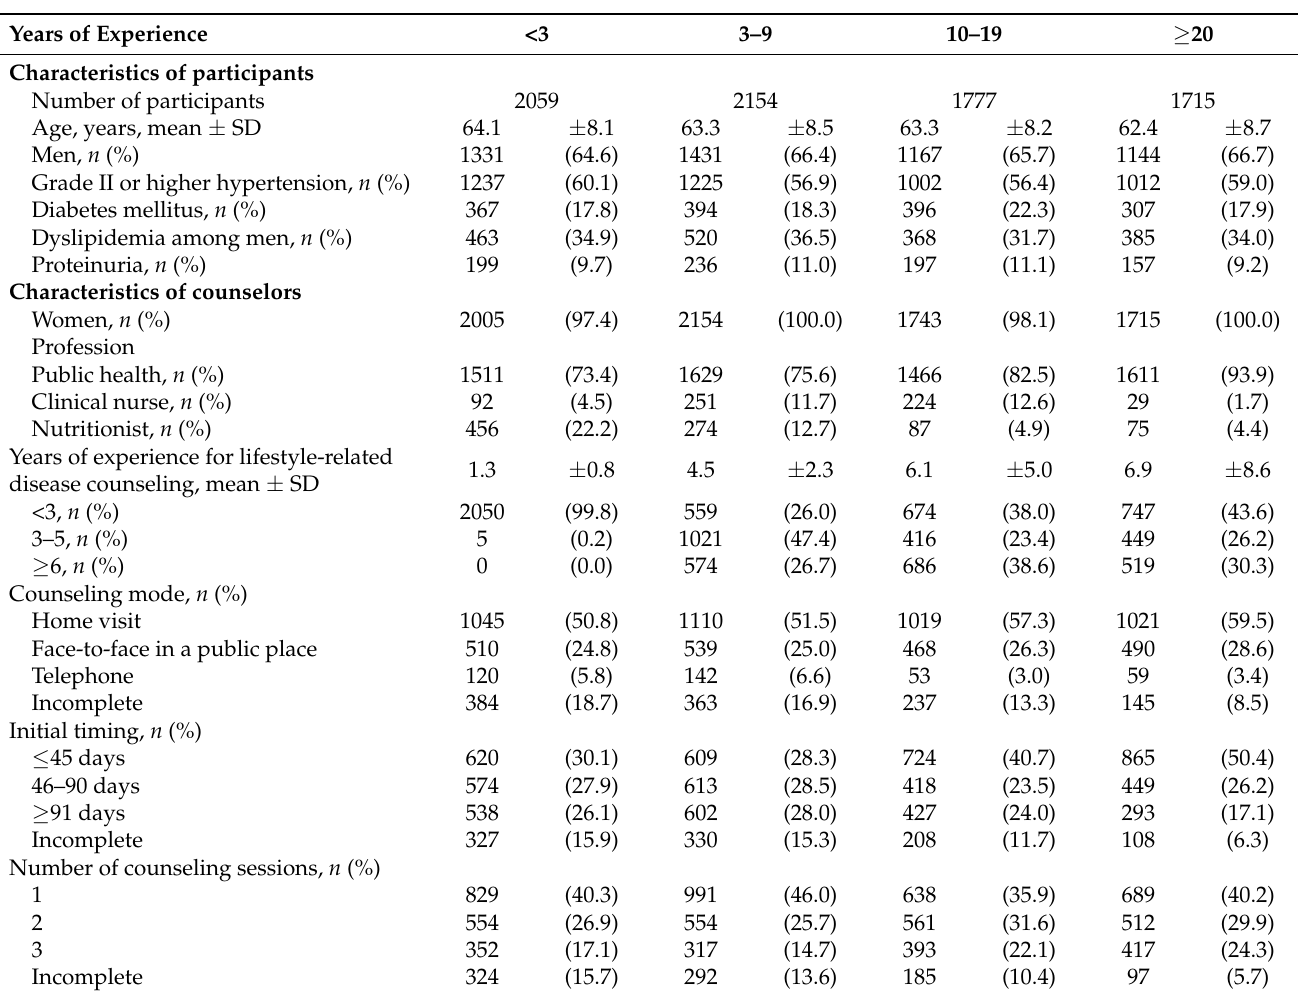
Table 3. Characteristics of the participants and counselors according to the experience in general